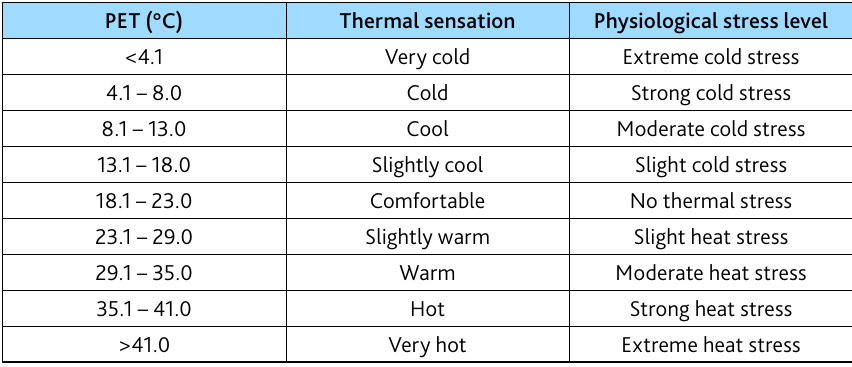
Table 2. PET index threshold values for thermal sensation and the physiological stress level of humans (after Matzarakis and Mayer,